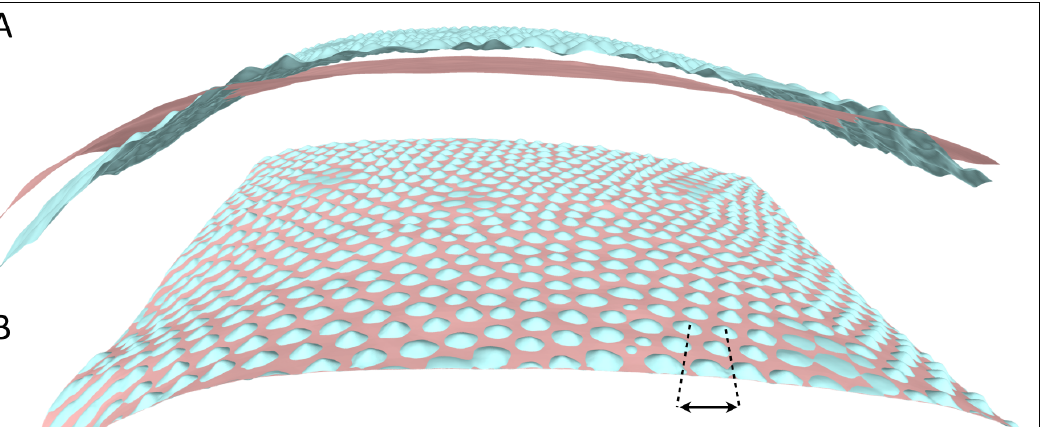
Fig 6. 3D reconstruction of a Phelsuma gecko skin patch combining SFM and PS. A) The PS reconstruction (blue) produces accurate microgeometry but a biased overall geometry; The PMVS reconstruction (pink) yields an accurate overall geometry and no microgeometry. B) Integration of the low- frequency and high-frequency geometries with a linear optimisation algorithm yields both a correct overall geometry and the body scales microgeometry. Double-headed arrow: the distance between two neighbour scales is about 150 μ m.